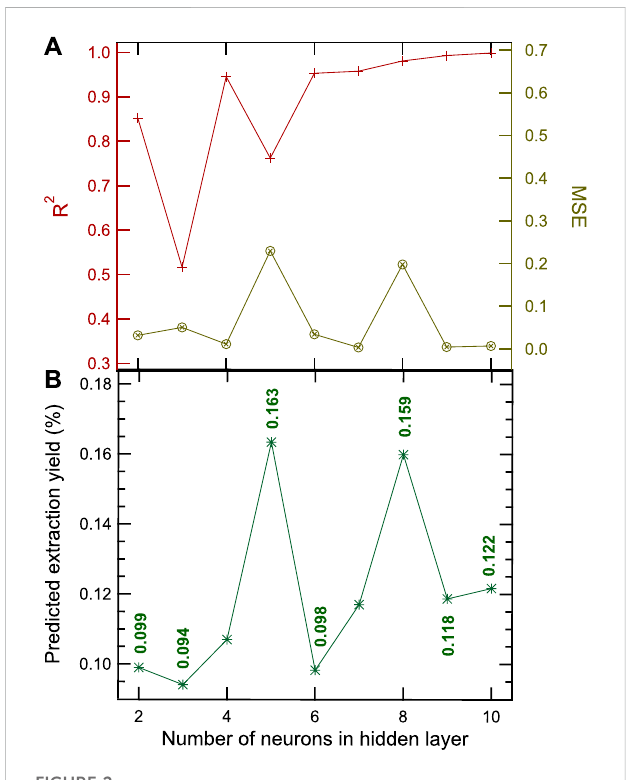
FIGURE 2 Results of the MLP neural network learning process with (A) the optimization process of the fi tting parameters MSE and R 2 for the testing set and (B) yield prediction for the veri fi cation set - 350 g.